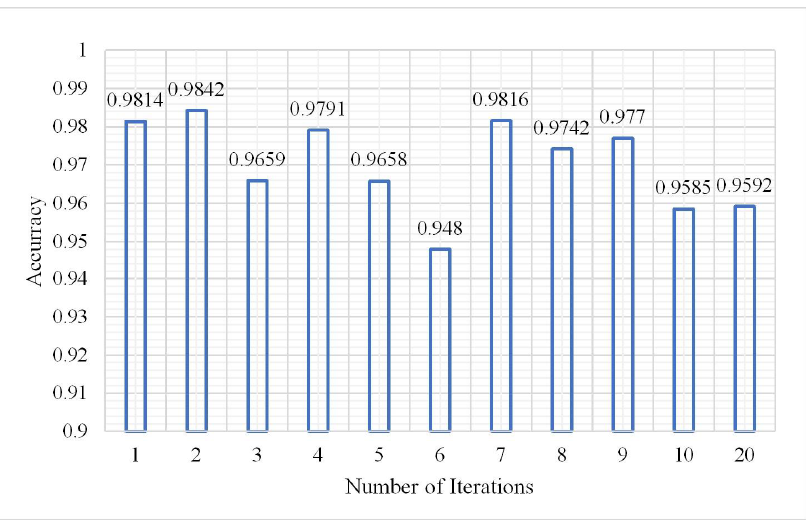
Figure 16. Change in overall accuracy.